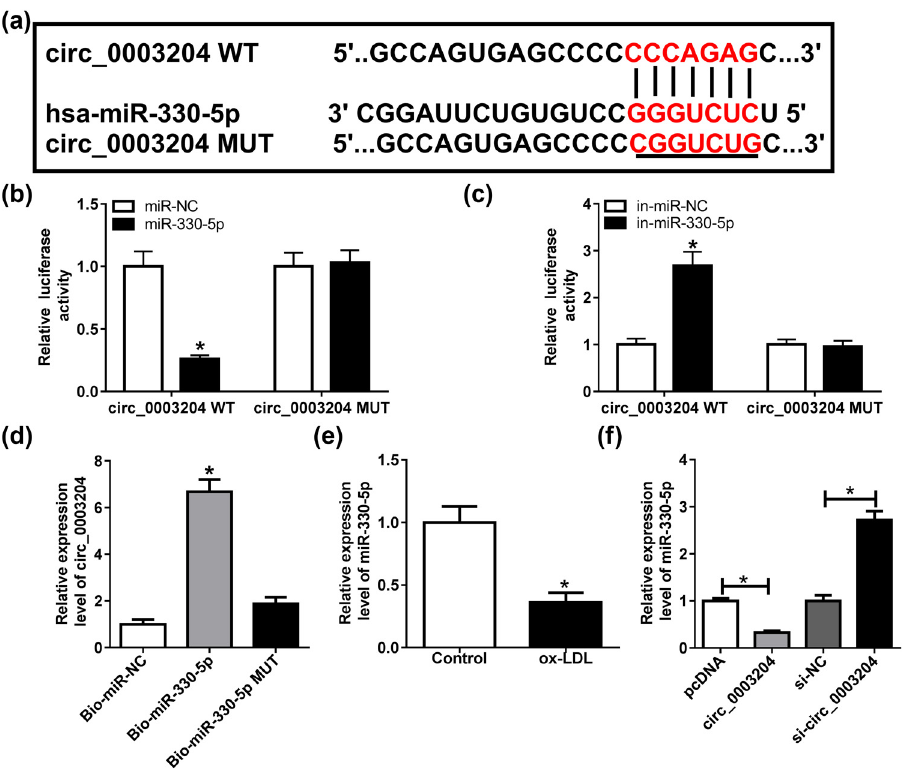
Figure 3: circ_0003204 served as a sponge of miR - 330 - 5p. ( a ) The fragments of circ_0003204 containing the binding sites or mutant binding sites of miR - 330 - 5p were exhibited. ( b and c ) Dual - luciferase reporter assay was performed to determine the luciferase activity of circ_0003204 WT or MUT vector in ox - LDL - induced HUVECs. ( d ) RNA pull - down assay was used to verify the interaction between circ_0003204 and miR - 330 - 5p. The relative expression of circ_0003204 in Bio - miR - 330 - 5p probe or Bio - miR - 330 - 5p MUT probe was detected using qPCR. ( e ) The miR - 330 - 5p expression in ox - LDL - induced HUVECs or normal HUVECs was assessed by qPCR. ( f ) HUVECs were transfected with circ_0003204 overexpression plasmid or si - circ_0003204 or their negative controls ( pcDNA or si - NC ) , followed by treat - ment with ox - LDL. The qPCR was used to test the expression of miR - 330 - 5p. * P <